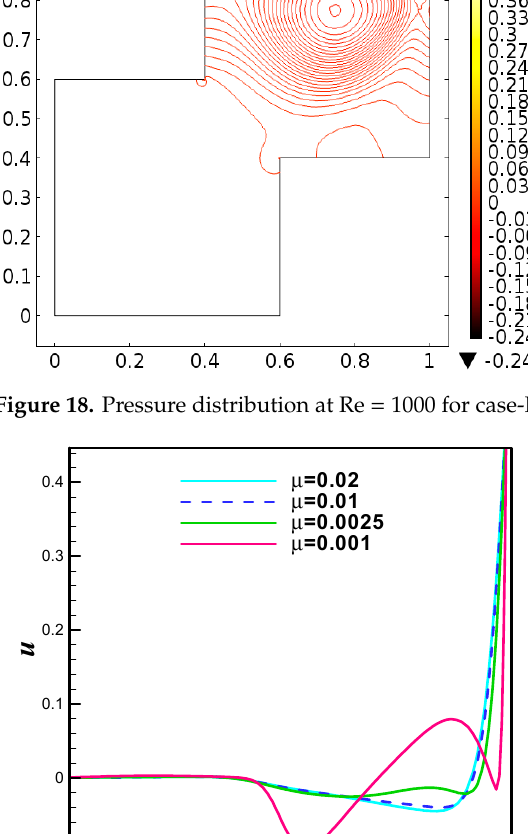
Figure 20. The v - velocity profile for case-I.